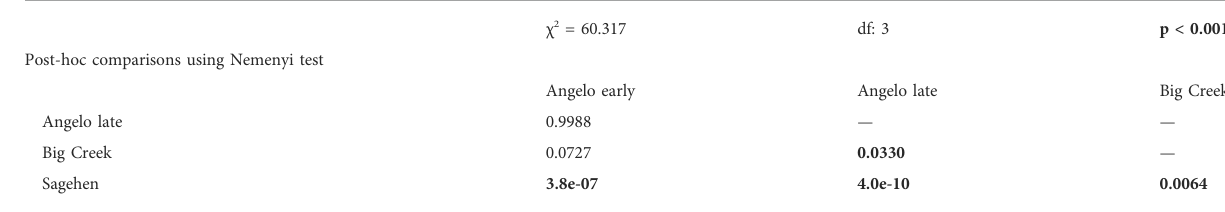
TABLE 4A Effect of population and treatment on gene expression responses to warming results of Kruskal-Wallis test to determine population differences for absolute Δ expression of genes in the daily warming treatment and the Nemenyi post-hoc test. Kruskal-Wallis test χ 2 = 60.317